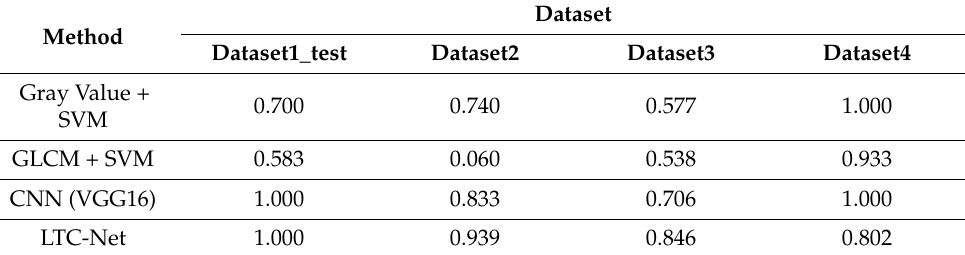
Table 5. Recall of gangue.